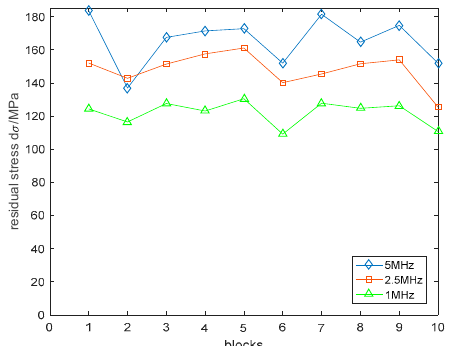
Figure 8. Residual stress measured at 5 MHz, 2.5 MHz, and 1 MHz for the S2 specimen (the detection area of samples had been divided into 10 equal blocks, and the mean value of the residual stress was obtained from 10 different blocks for each sample).